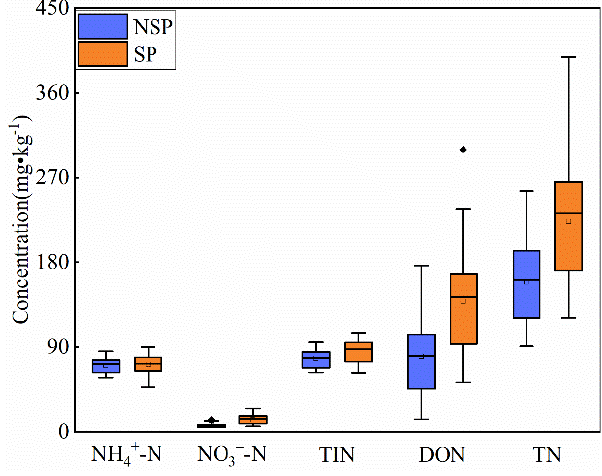
Figure 4. Concentrations of absorbed nitrogen species in the WJD reservoir.